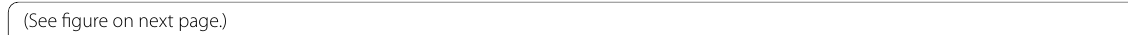
images(See figure on next Fig. 4 BSE images ( a , c , e , g ) of maps 1, 2, 3 and 4, respectively (indicated in Fig. 3). High‑resolution non‑confocal SR‑XRF scans displayed as RGB images showing the K‑line intensities of Ca (R), Fe (G), and S (B) (b, 250 nm step size), Ca (R), Fe (G), and Cr (B) (d and h, 100 nm step size) and Ca (R), Fe (G), and Mn (B) (f, 200 nm step size). Red/white crosses mark the points, where confocal point analyses were performed, the results of which are shown in Tables 2 and 3. Due to difficult sample positioning, there is a slight misalignment between the BSE and SR‑XRF